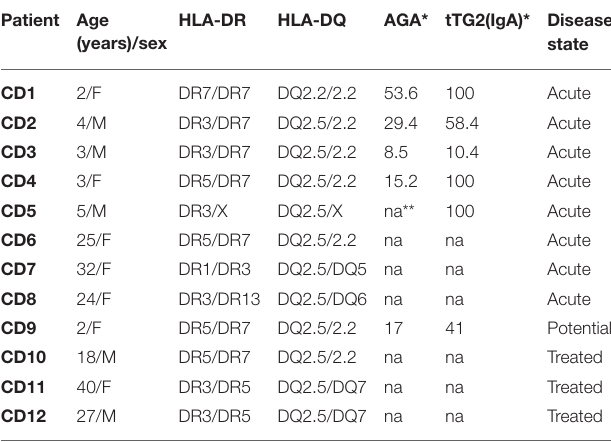
TABLE 1 | Cohort of celiac disease patients enrolled in the